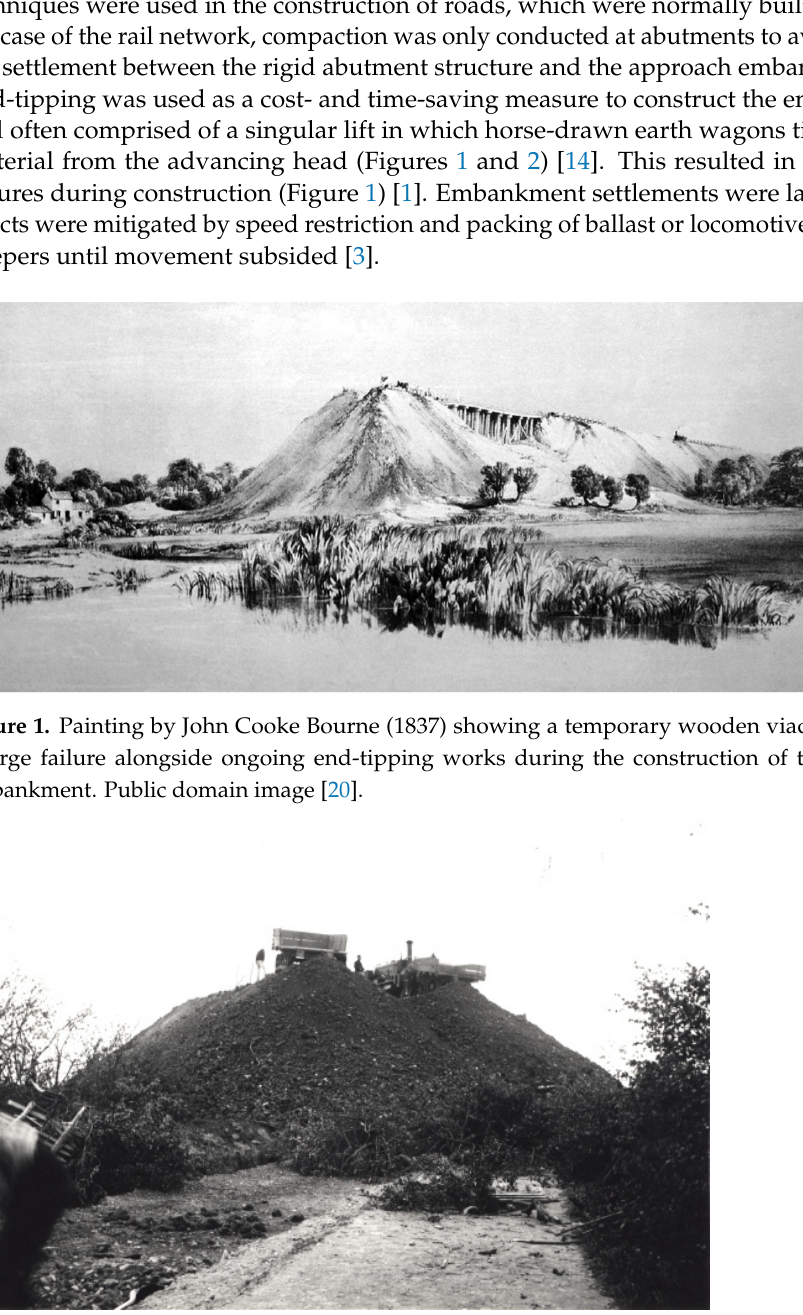
Figure 2. Image showing end-tipping construction method, used during early construction of the British railway, at Blackbird Road, Leicester circa 1897 (Photo reproduced with permission of Record Office for Leicestershire, Leicester and Rutland).